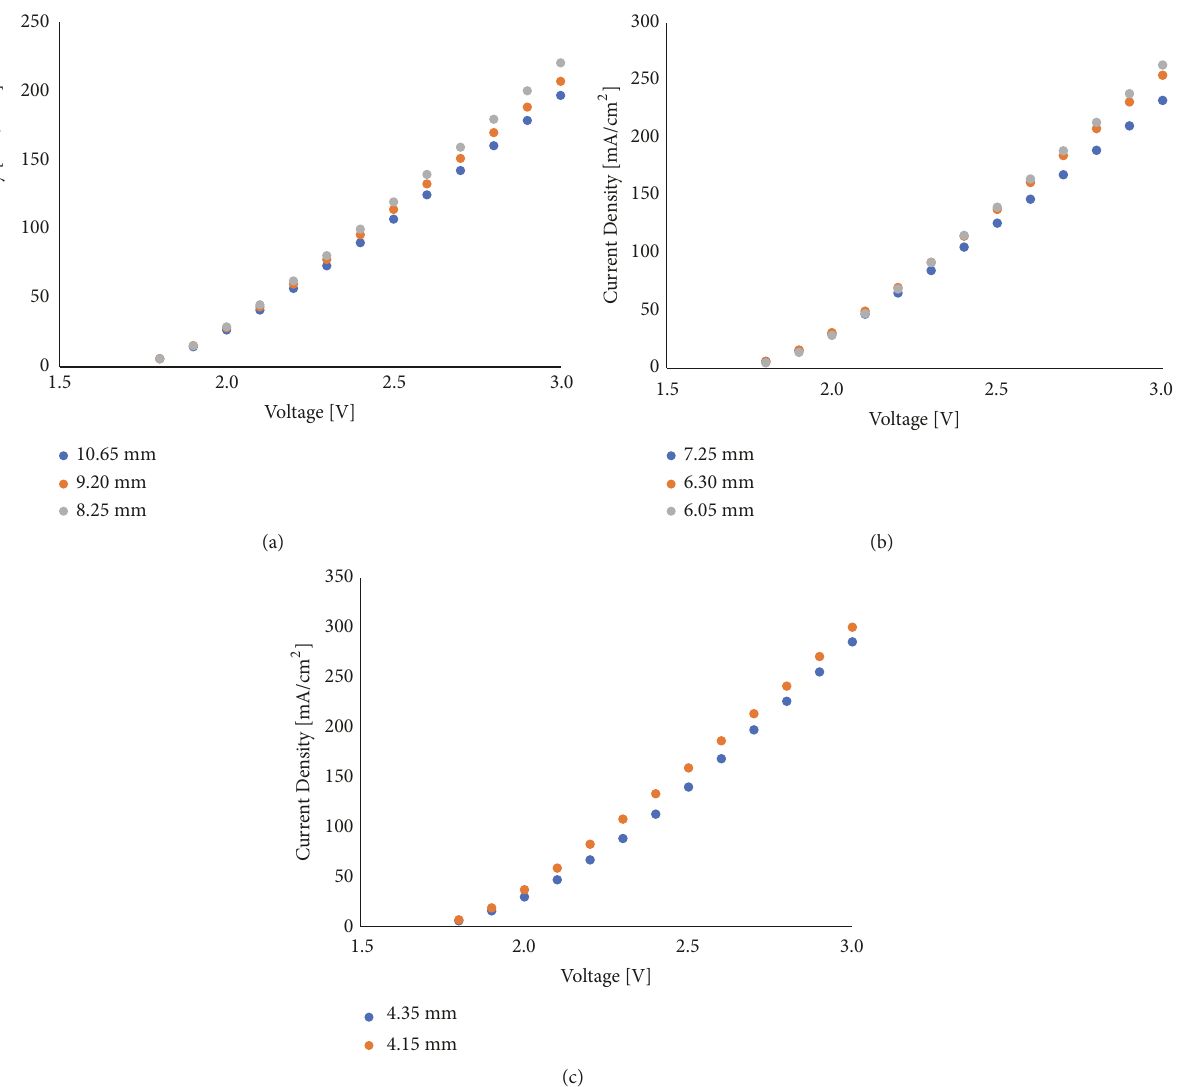
Figure 2: Polarization curves per unit area for the analysed distances between electrodes: (a) 10.65, 9.20, and 8.25, (b) 7.25, 6.30, and 6.05, and (c) 4.35 and 4.15